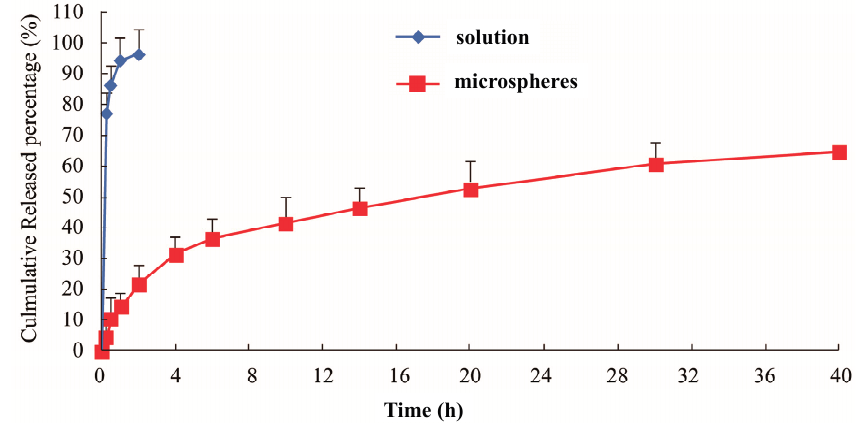
Figure 2. In vitro release of the lidocaine microspheres in human serum albumin